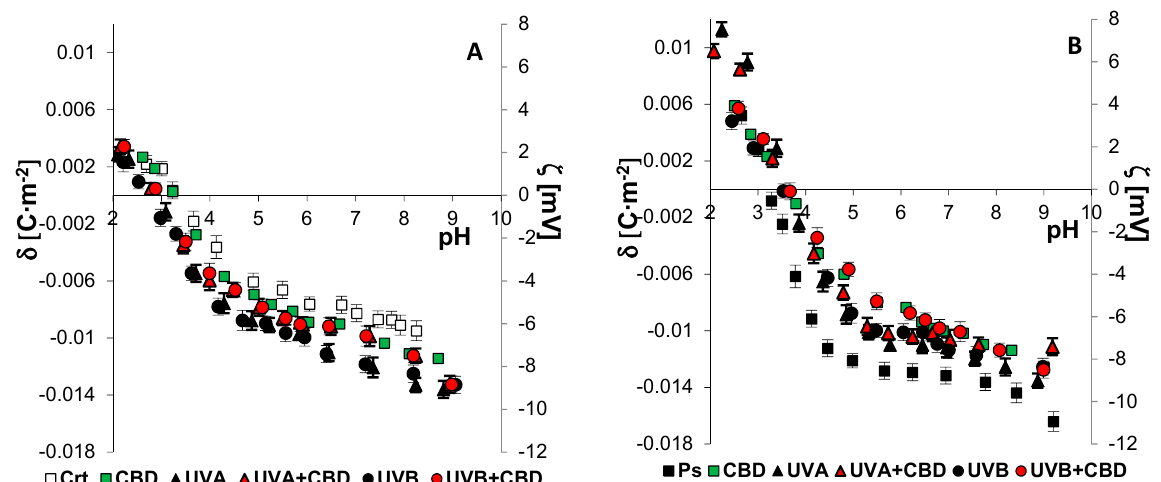
Figure 4. The surface charge density ( left axis ) and corresponding zeta potential ( right axis ) of keratinocytes isolated from skin of healthy subjects (Ctr) ( A ) ( n = 6) and psoriatic patients (Ps) ( B ) ( n = 6) exposed to UVA (30 J/cm 2 ) and UVB (60 mJ/cm 2 ) radiation as well as untreated and treated with CBD (4 µ M). The mean values ± SD are presented.